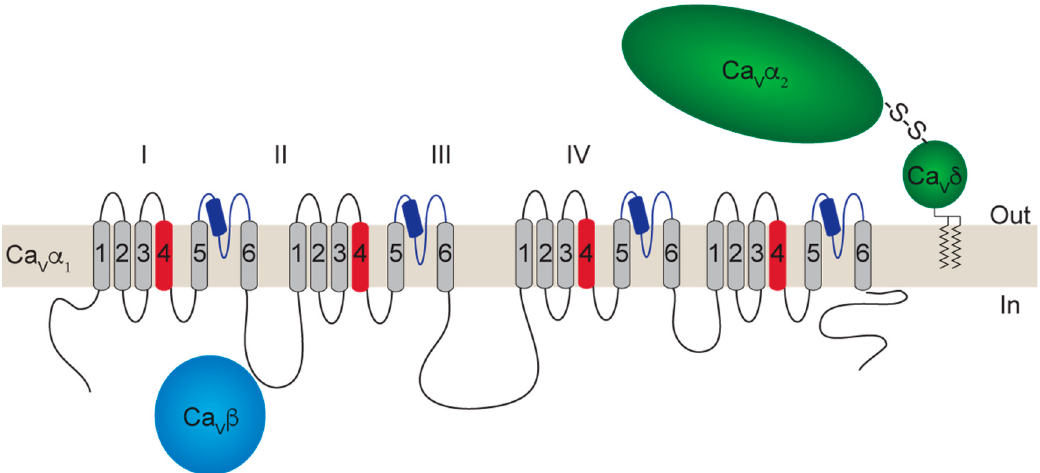
Figure 1. Schematic representation of a voltage-gated calcium channel (Ca V ) complex. The Ca V α 1 , Ca V α 2 δ , and Ca V β subunits are depicted. Transmembrane segments of the Ca V α 1 subunit (S1–6) are shown arranged in the four domains (DI-IV), the voltage sensors are indicated in red (S4), and the reentrant loop between S5 and S6 (P-loop) in dark blue. The glycosylphosphatidylinositol (GPI)-anchored Ca V α 2 δ is shown in green, and the cytoplasmic Ca V β subunit in light blue.